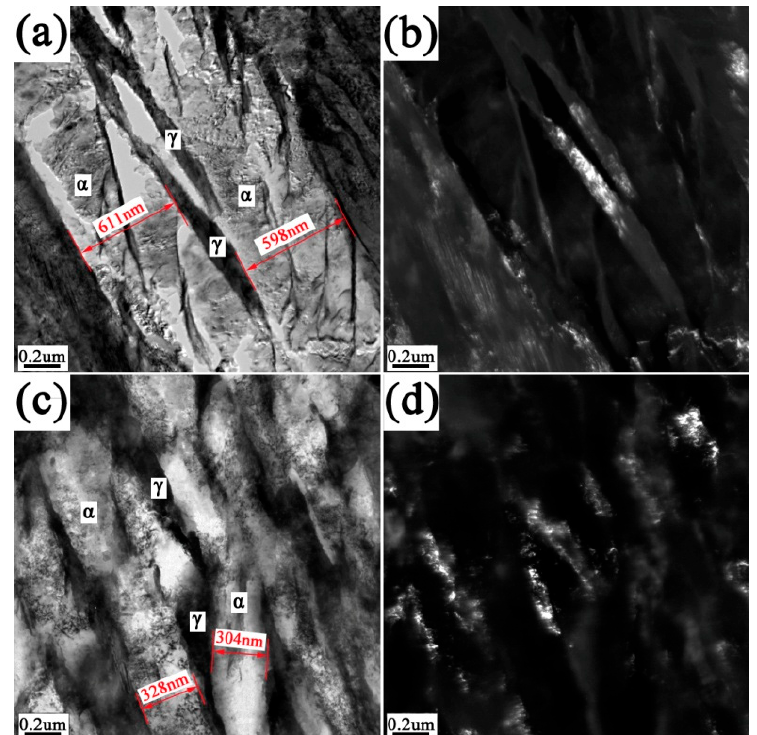
Figure 4. TEM investigations of samples at different conditions, ( a ) and ( b ) nondeformed sample isothermal transformed at 300 °C; ( c ) and ( d ) deformed with a strain of 0.3 followed by isothermal transformation at 300 °C. Blocky and film-like austenites are shown in dark (left) and bright (right) images, respectively.